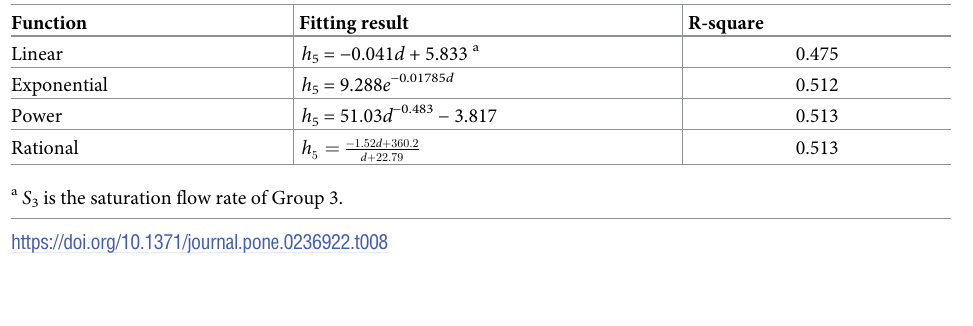
Table 8. Regression analysis between headway and d